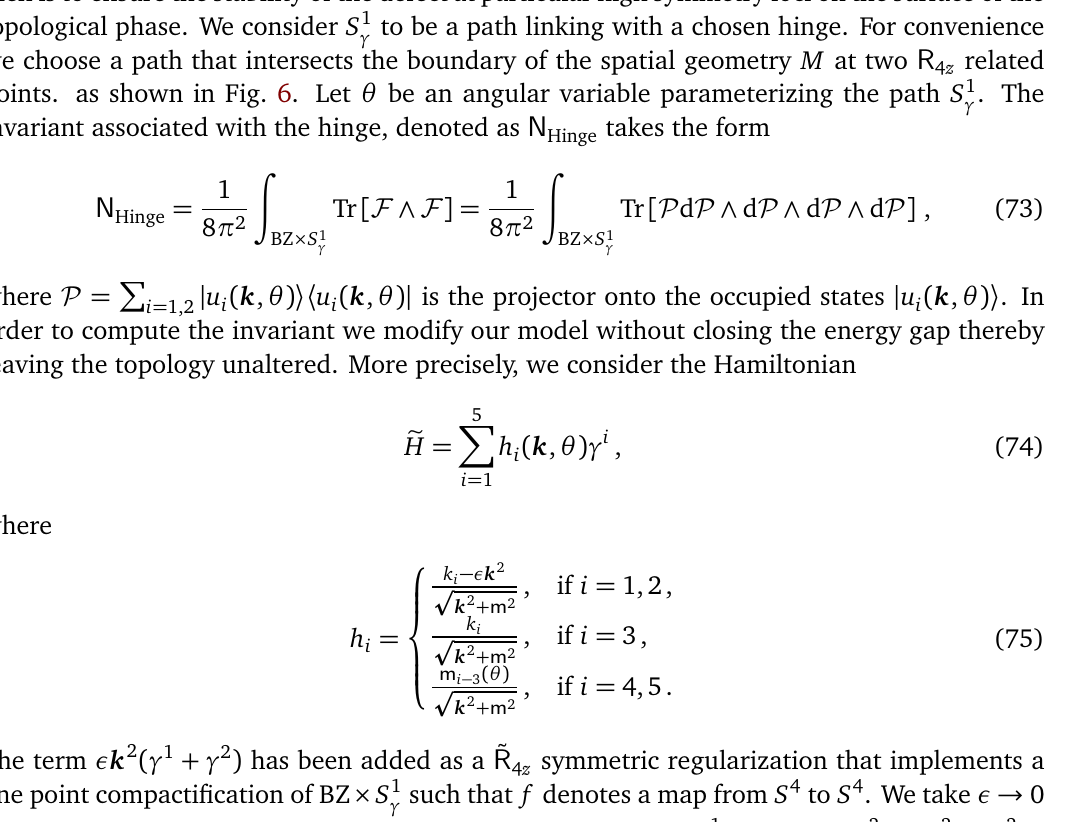
circumventing one of the sample γ